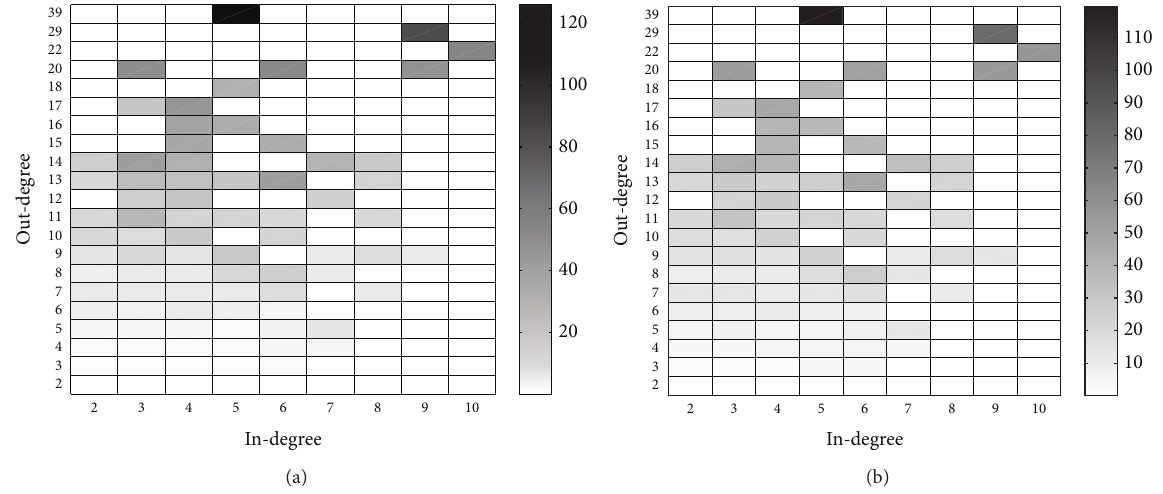
Figure 7: Results for 𝑢 𝑖,𝑗 from (a) simulations and (b) theoretical